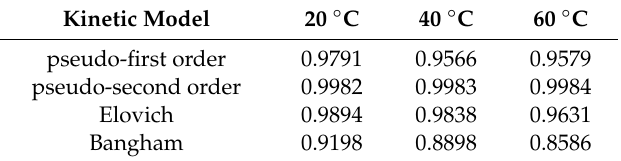
Table 3. Summary of the correlation coe ffi cients corresponding to di ff erent kinetic models